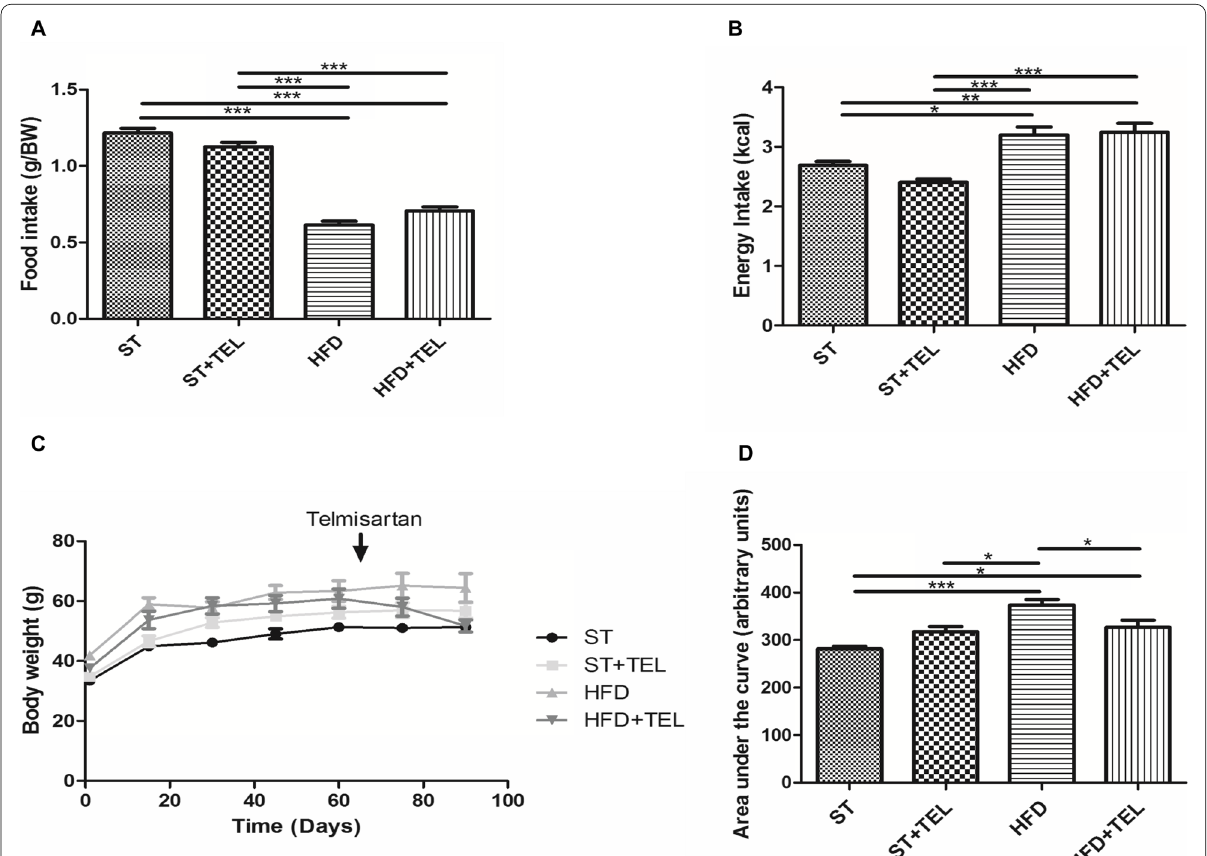
Fig. 1 Food intake, energy intake, and body weight in mice treated with Telmisartan and fed with a standard and high-fat diet (ST, ST HFD TEL). Food intake ( a ), energy intake ( b ), body weight ( c ), and area under the curve ( d ). Data are presented as mean + and *** p <0.001